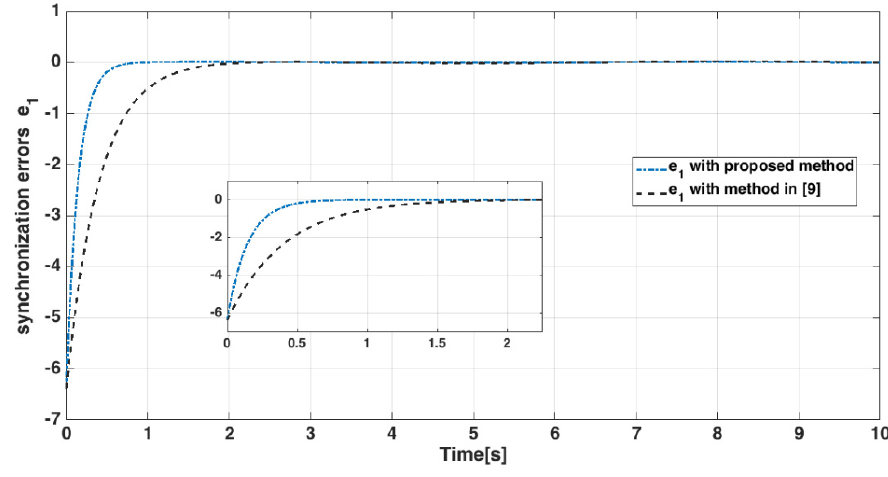
Figure 14. State error 𝒆 𝟏 of master-slave systems.